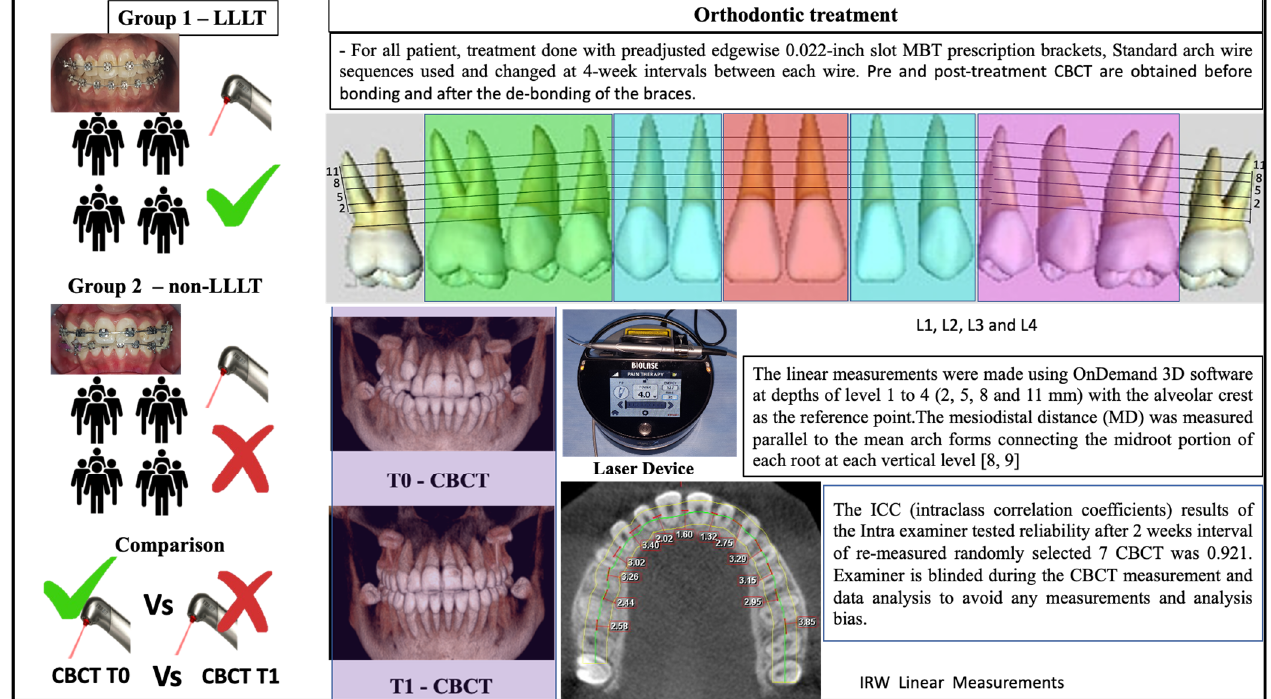
Figure 2. Details of LLLT and IRW linear measurements.